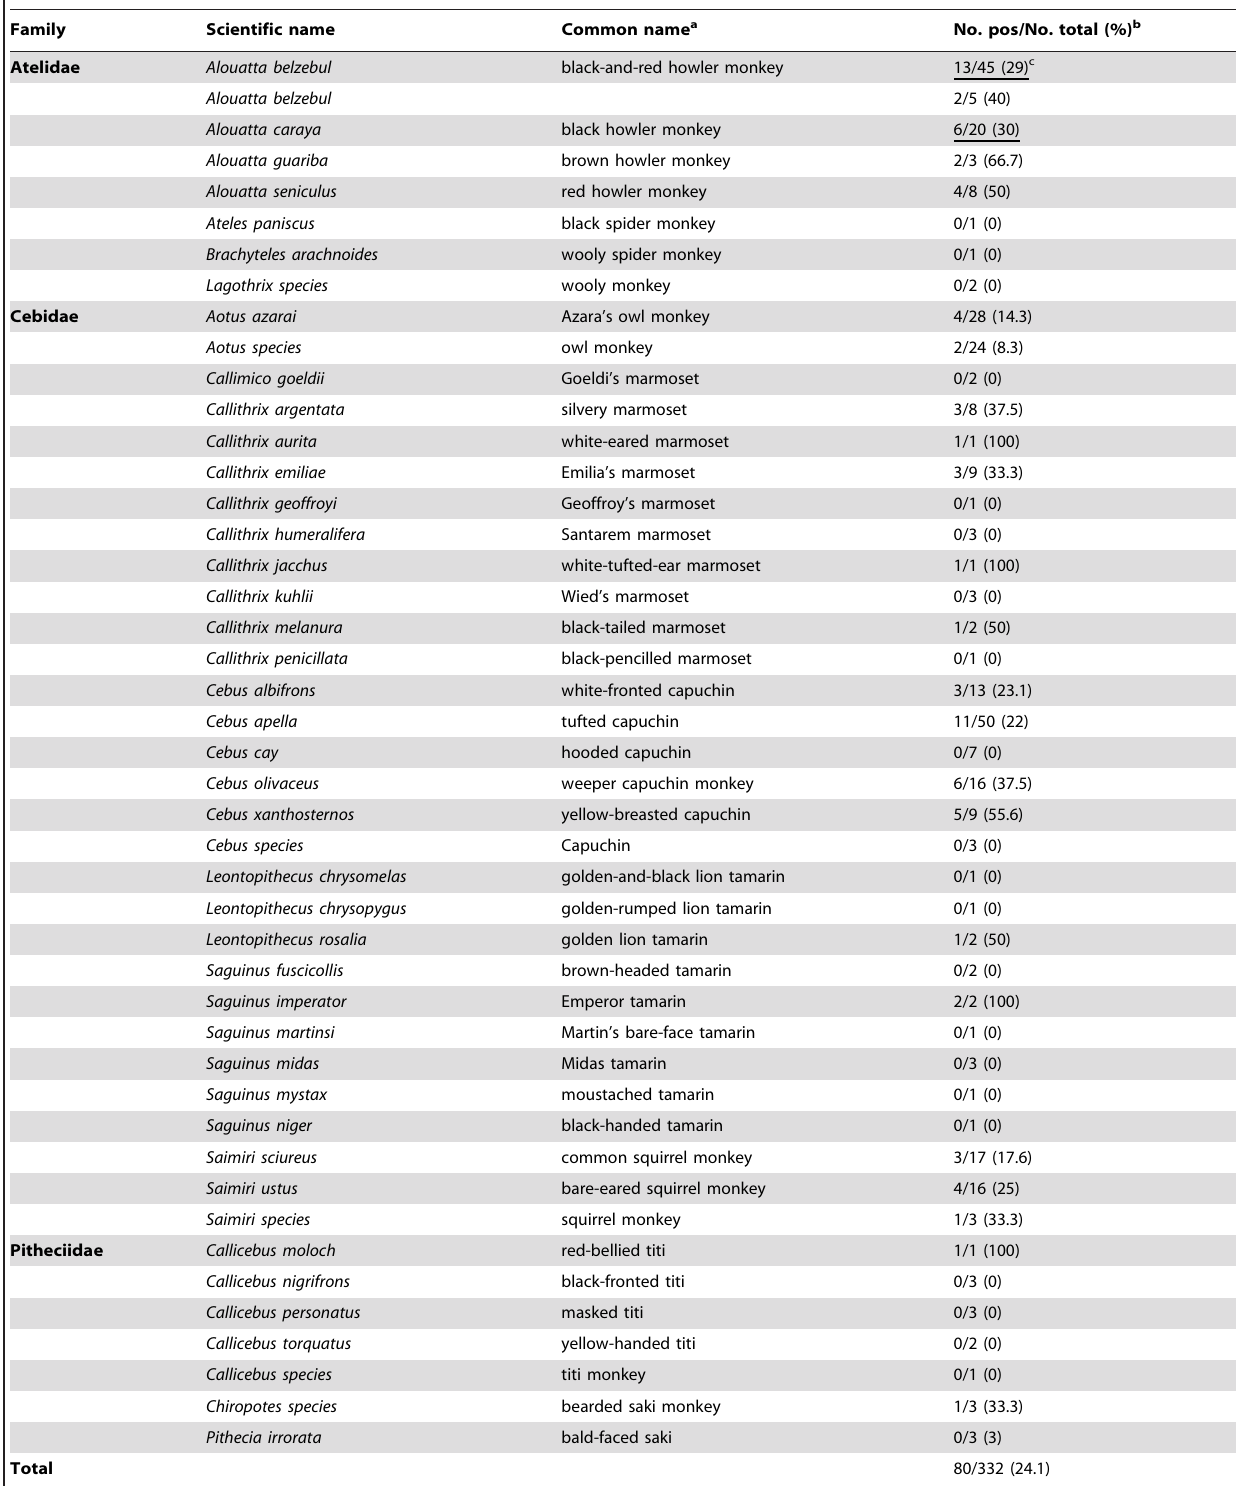
Table 2. Molecular detection and distribution of SFV in New World primates from Brazil.